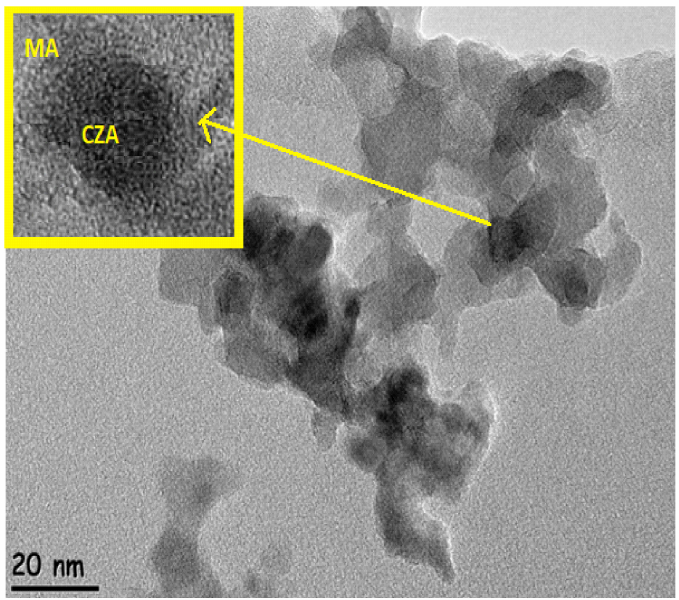
Figure 6. HR-TEM images of the CZA-MA